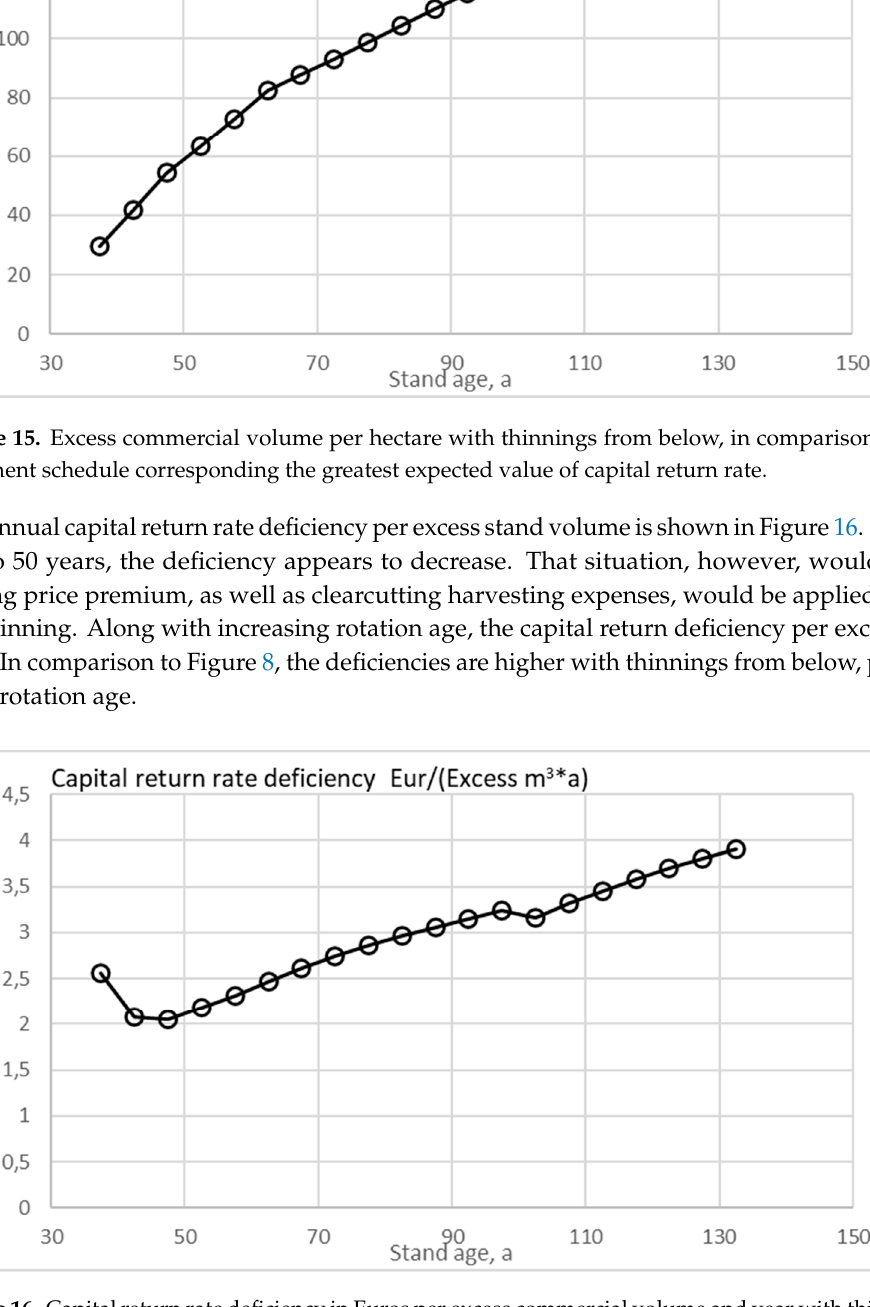
Figure 16. Capital return rate deficiency in Euros per excess commercial volume and year with thinnings from below, in comparison to the treatment schedule corresponding to the greatest expected value of capital return rate.